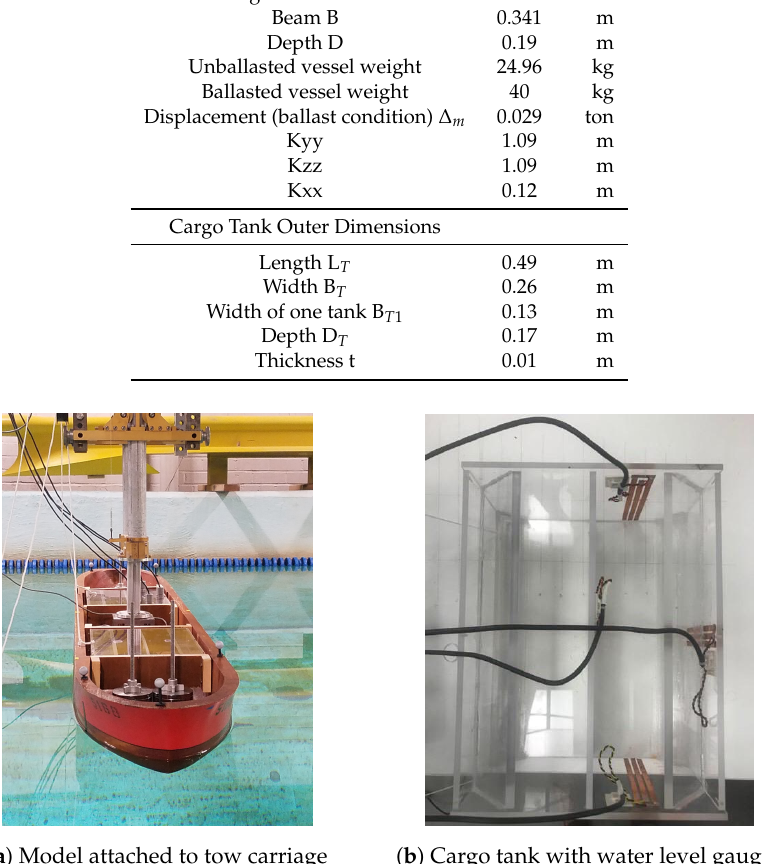
Figure 8. Model attached to heave post and cargo